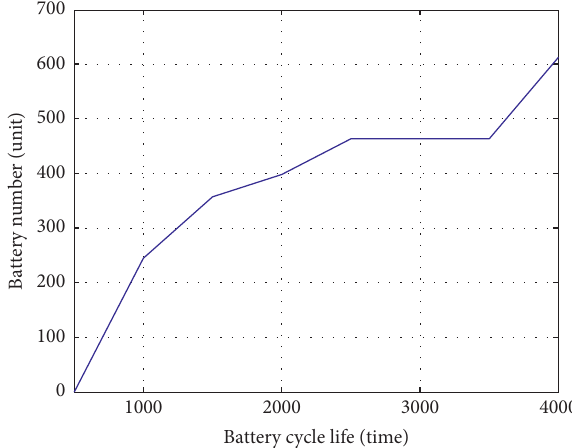
Figure 9: Relationship between the battery number and cycle